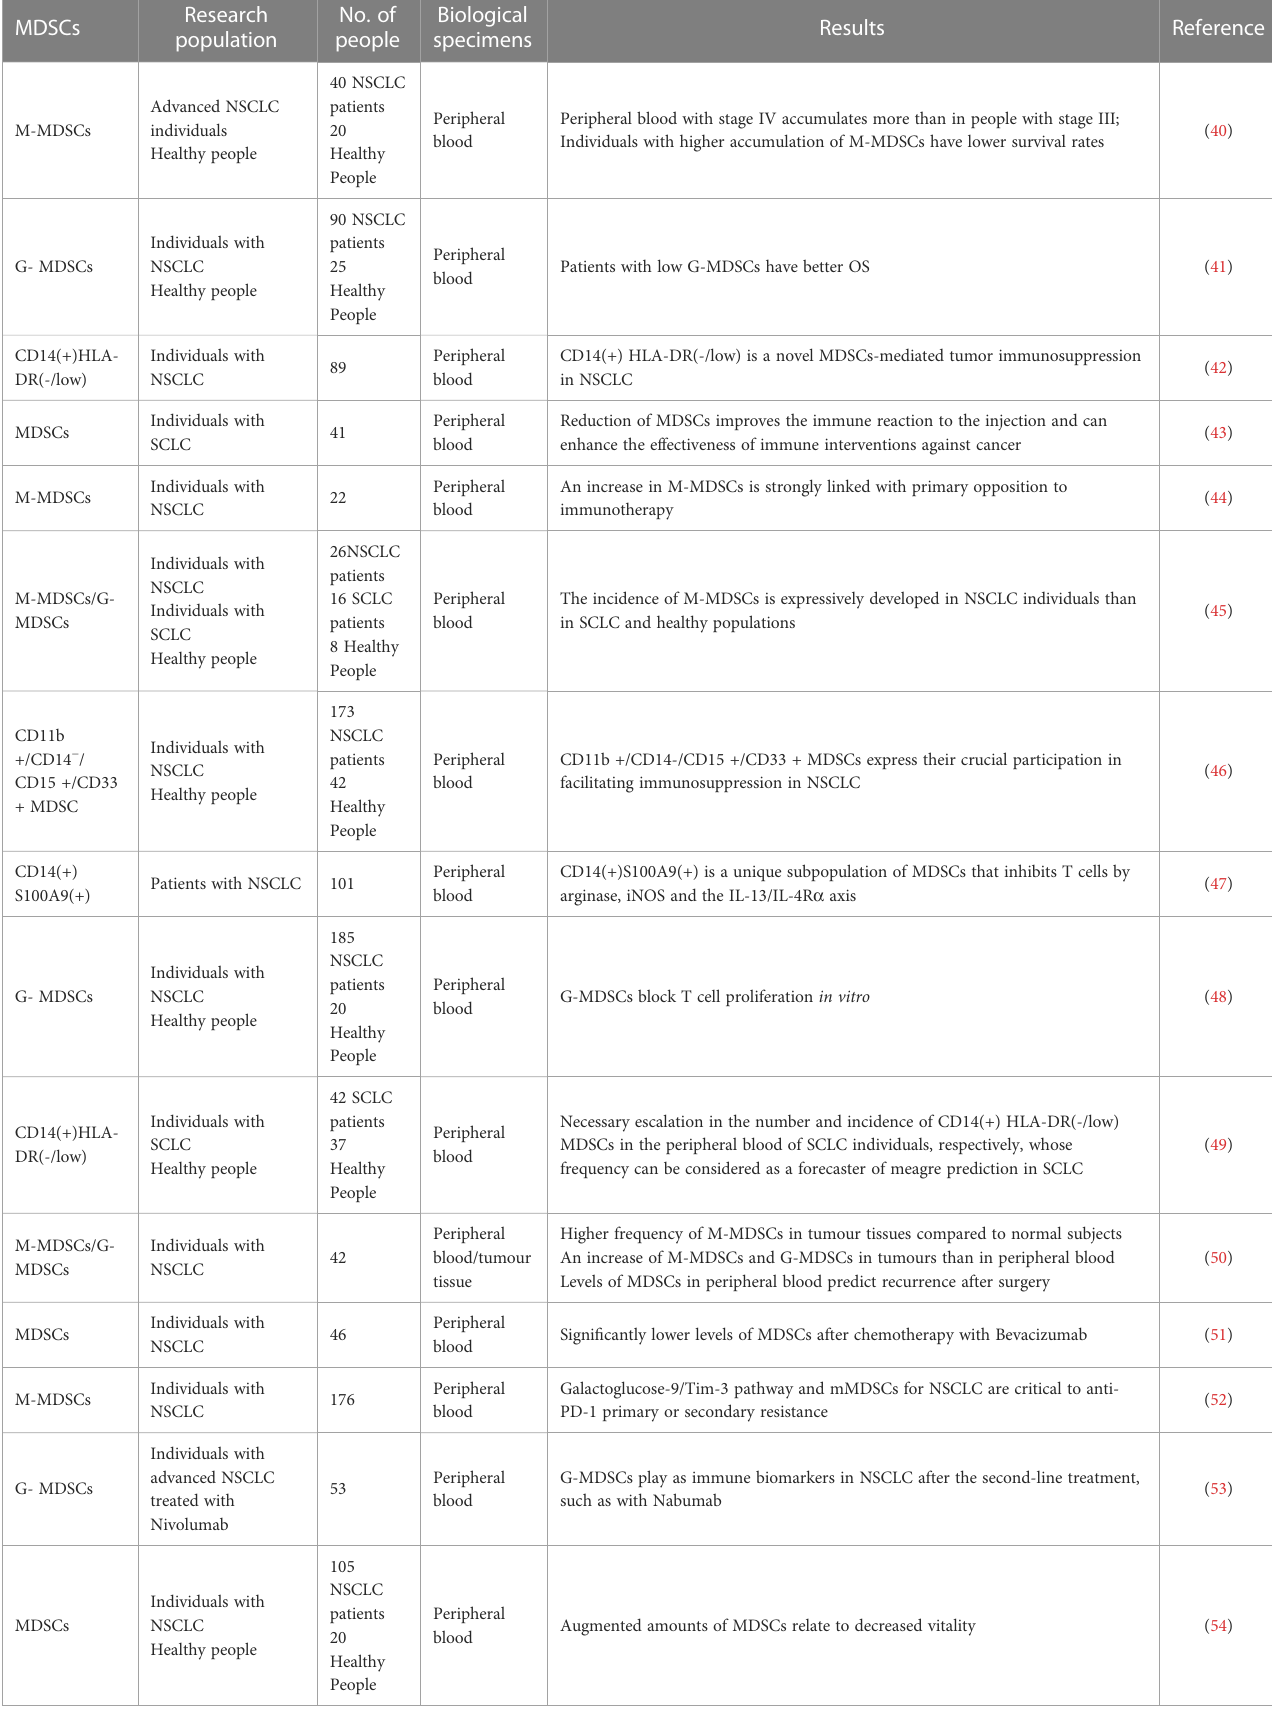
TABLE 1 Lung cancer clinical studies of